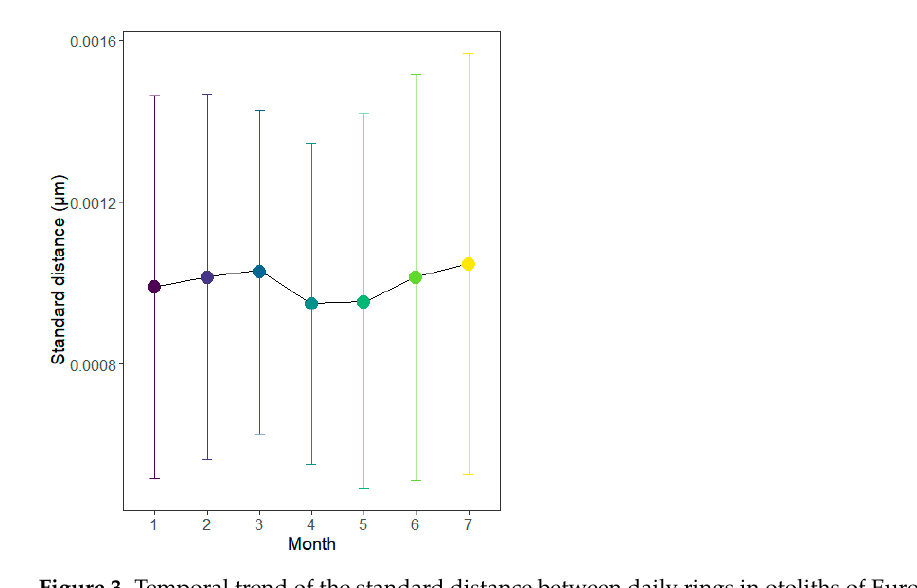
Figure 3. Temporal trend of the standard distance between daily rings in otoliths of European hake females captured in 2017. Points represent the mean and whiskers the standard deviation.